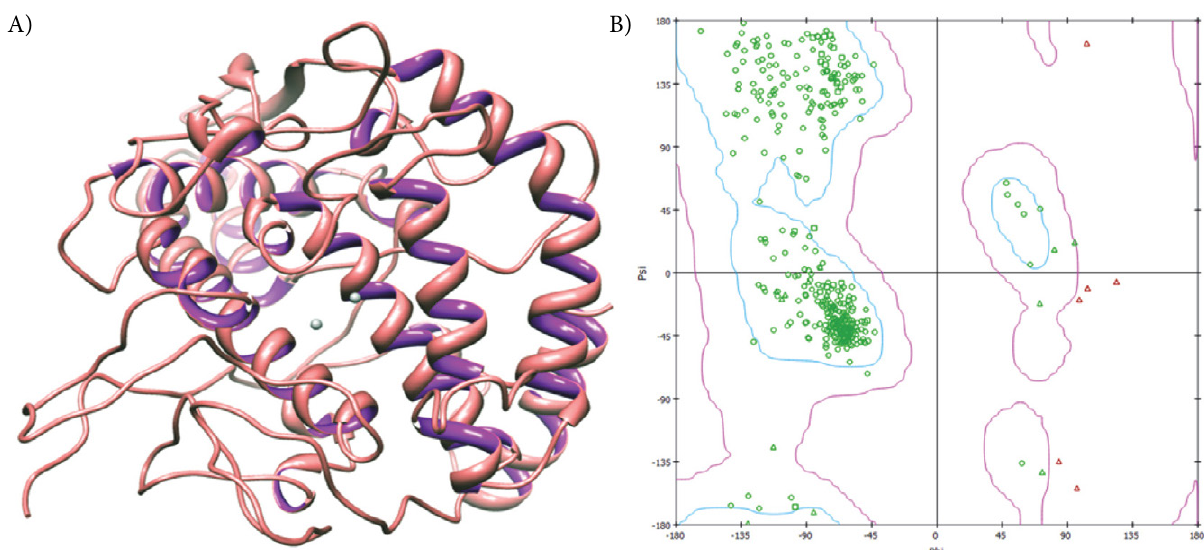
Figure 5. The overall protein structure (A) of tyrosinase and its Ramachandran graph